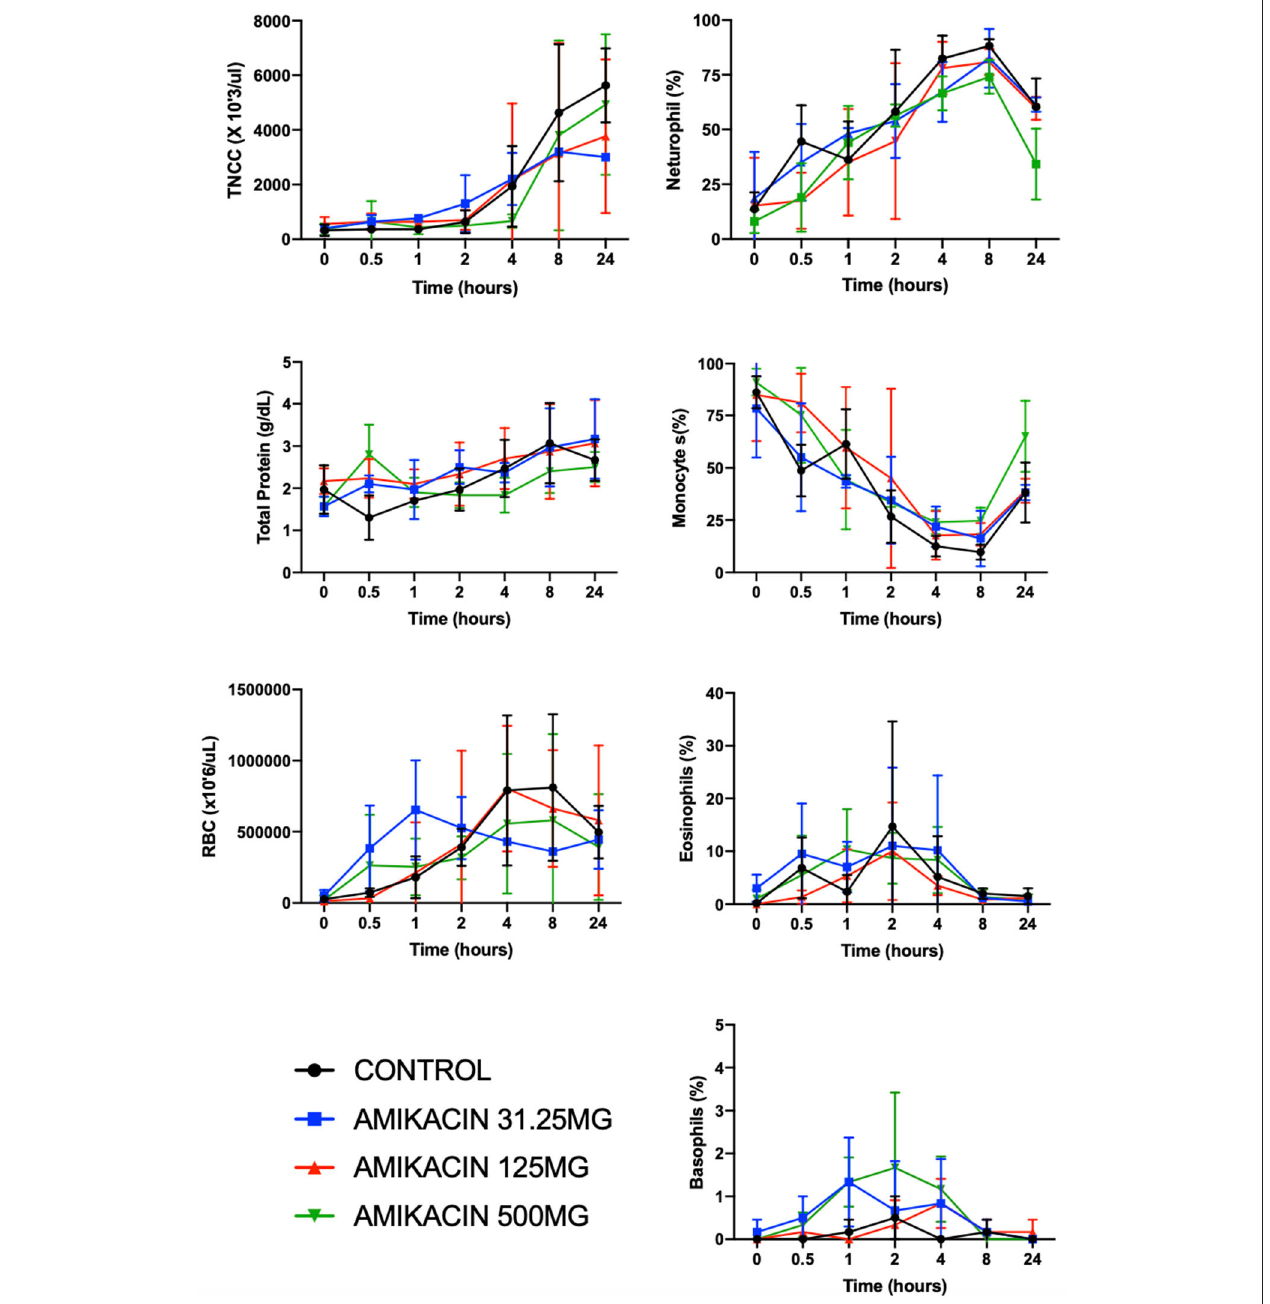
FIGURE 5 | Clinicopathologic parameters for synovial fluid following a single intra-articular administration of amikacin in three treatment groups. Fluid analysis on synovial fluid samples obtained from three horses per group was performed on all samples for total nucleated cell count, total protein, and red blood cell count and leukocyte differential ( y -axes are not equivalent across graphs). There were significantly increased neutrophils (in percent) and decreased monocytes (in percent) with repeated arthrocenteses over time. Results are expressed as the mean ± SD.